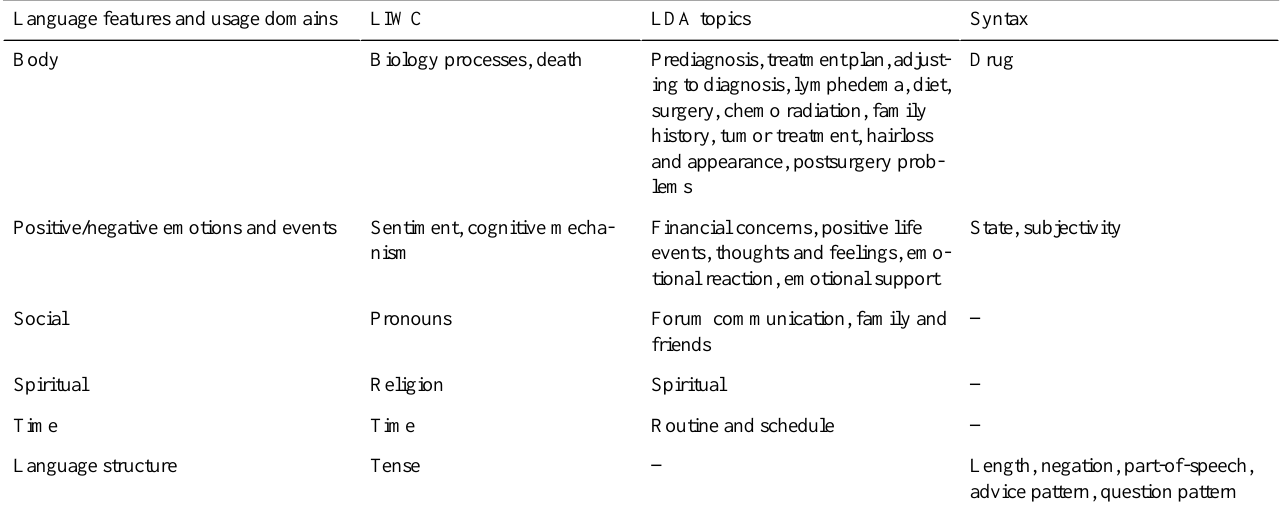
Table 4. Mapping of language features onto language usage domains.